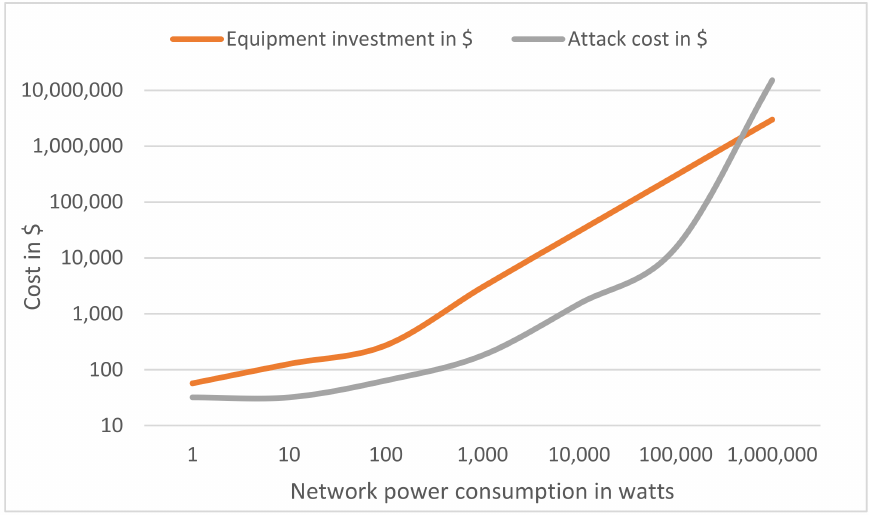
Figure 9. Power consumption and costs for PoW